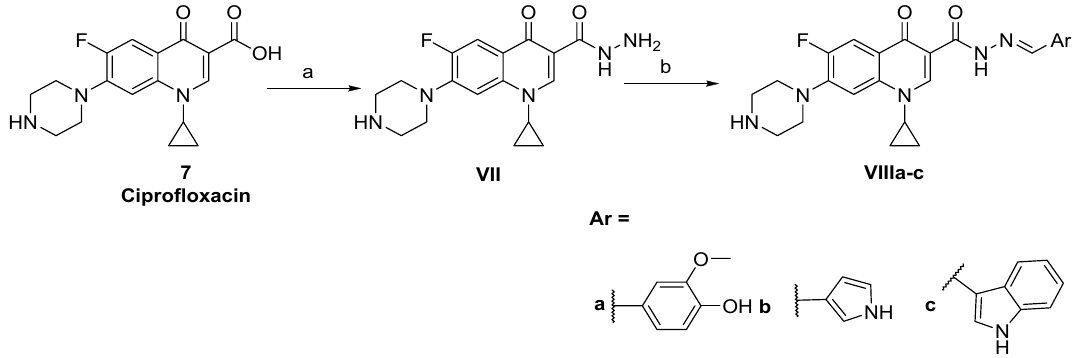
Figure 7. Synthetic pathway of ciprofloxacin derivatives. Generated using ChemDraw 2021 (https:// perki nelme rinfo rmati cs. com/ produ cts/ resea rch/ chemd raw) 19 . Reagents and conditions: (a) NH 2 NH 2 80%, reflux, 24 h (30%); (b) ArCHO, ethanol, reflux, 6 h